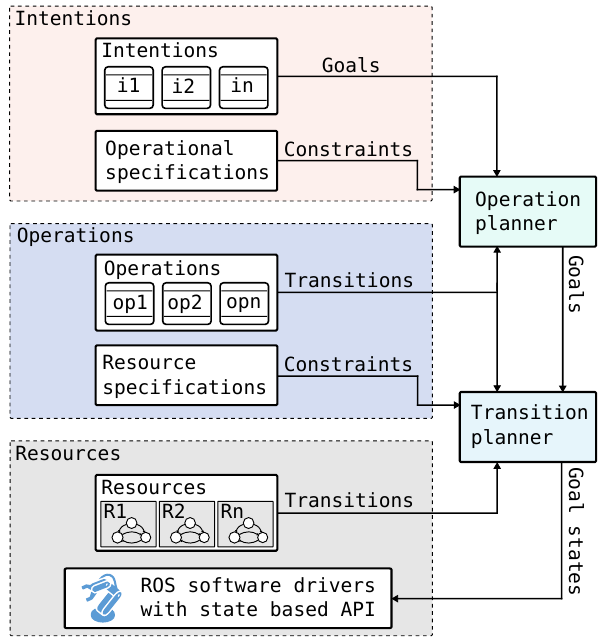
Figure 3. Overview of the SP control